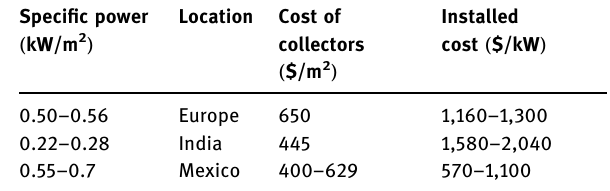
Table 14: Installed costs for CSP plants with PTCs [ 158 ]